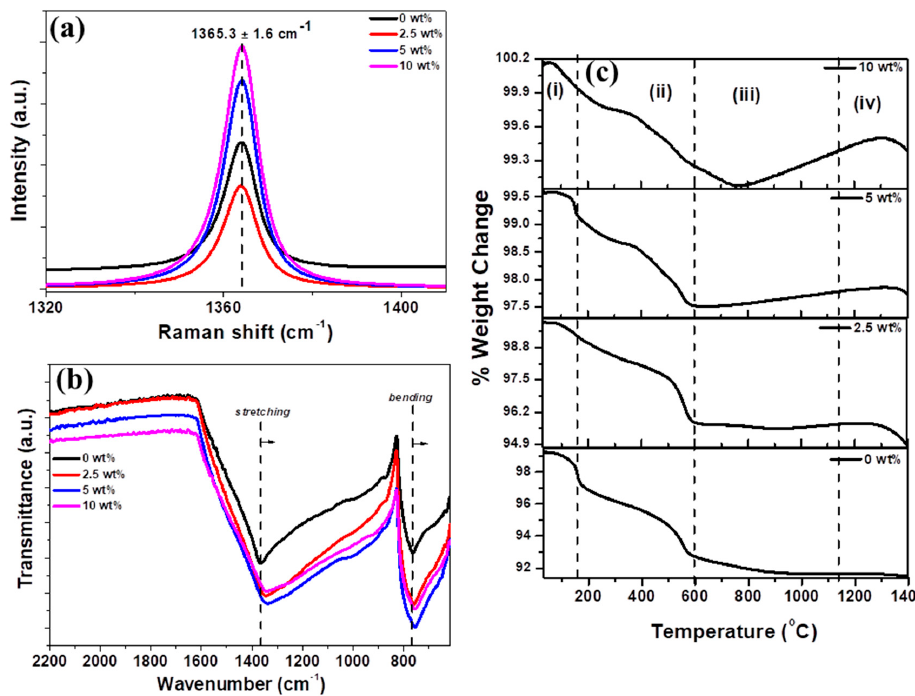
Figure 3. ( a ) Raman spectra, ( b ) FTIR spectra, and ( c ) TGA profiles for BNNS samples annealed at 1200 °C after the addition of 5 wt% Li 3 N and 0–10 wt% BaF 2 .